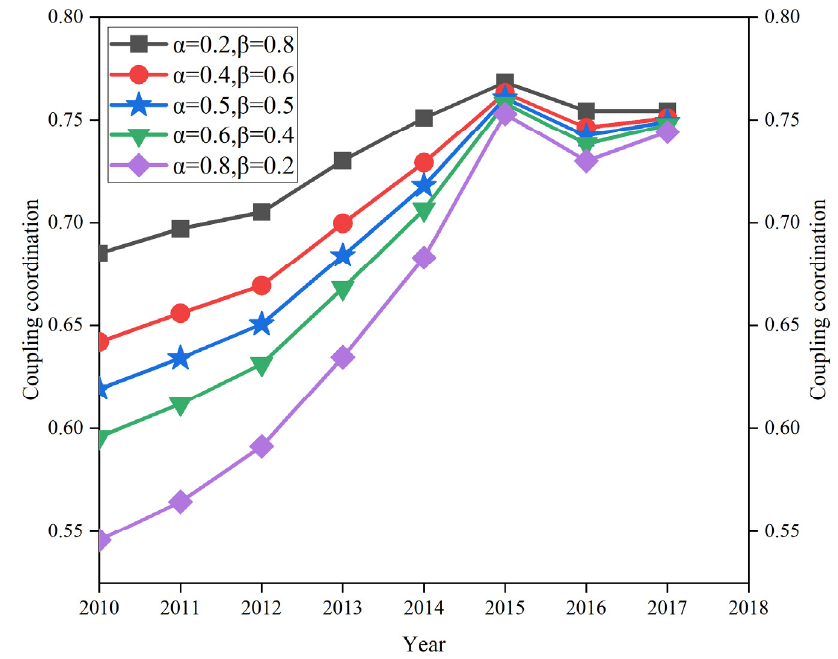
Figure 5. Change of coupling coordination degree of green finance and ecosystem service demand in Jiangsu Province based on traditional coupling coordination degree model.